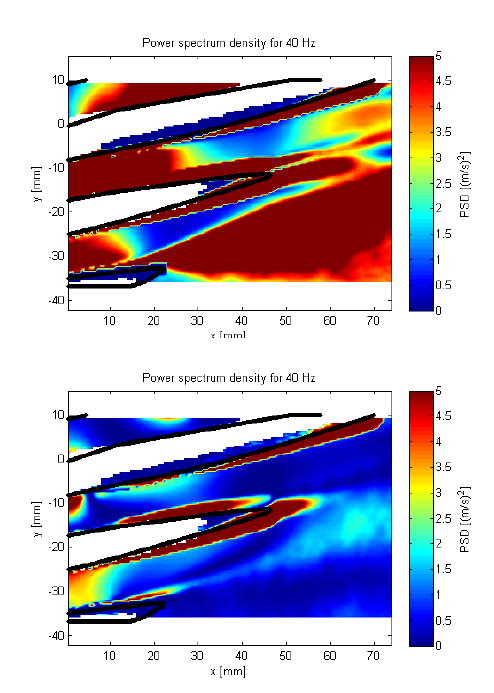
Fig. 9a, b. PSD value distribution for 40 Hz for both vel. components for turbine cascade, excited at φ = 180°